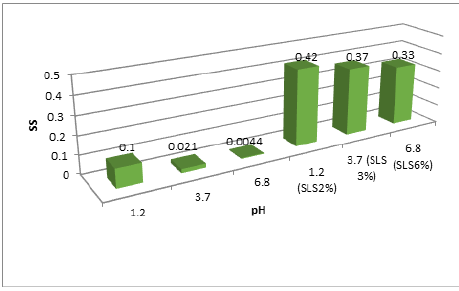
Figure 1. Saturated solubility of pure ITZ at different pH.